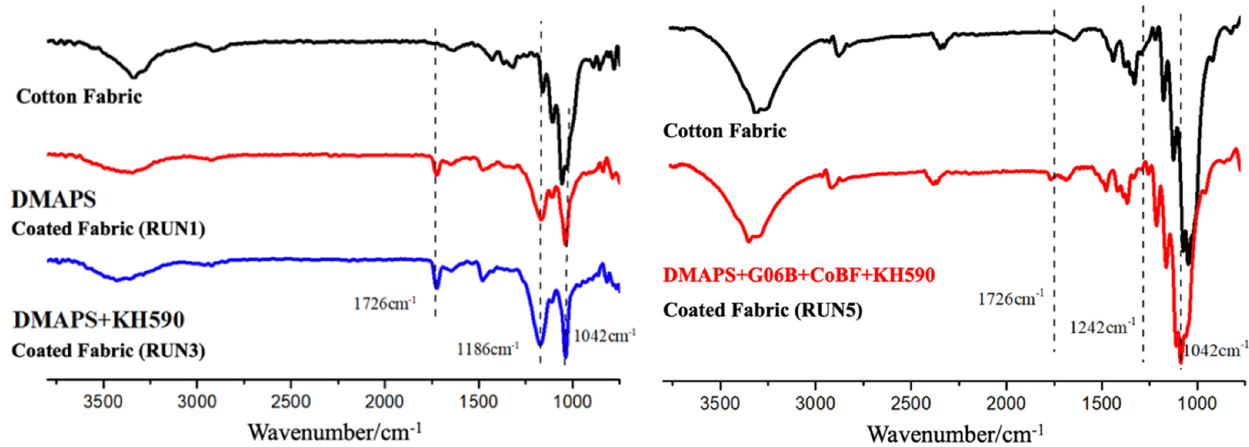
Figure 4. The FTIR spectrum of cotton fabric with the betaine copolymer ‐ coating treatment.